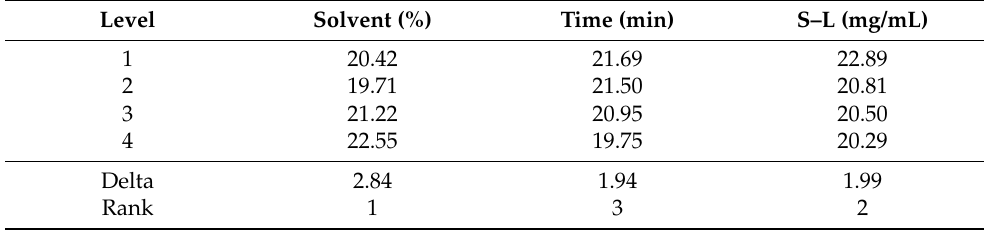
Table 2. The calculated SN ratio of AA response for solvent concentration, extraction time, and solid-to-liquid ratio. Level Solvent (%) Time (min) S–L